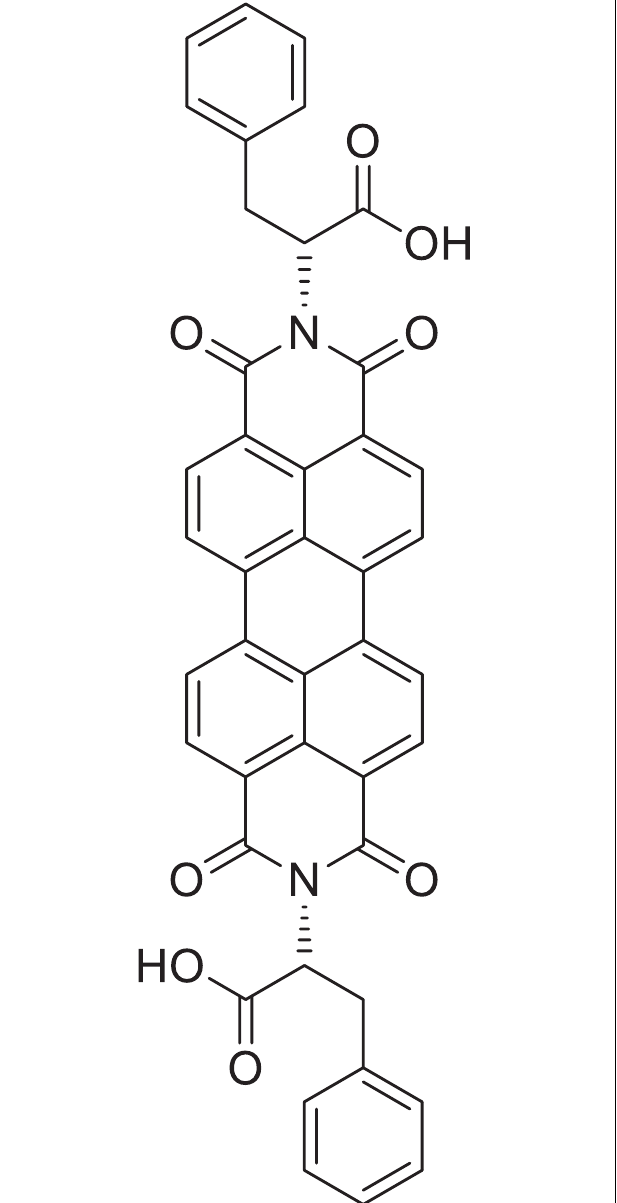
FIGURE 2 | (A) UV-visible spectra of D-PBI aqueous solutions at different concentrations in the 420–650 nm range; (B) A comparison of UV-visible spectrum of an aqueous solution of D-PBI 10 − 6 M (multiplied by 30 times) and of an aqueous solution of D-PBI 5 × 10 − 5 M; (C) Emission